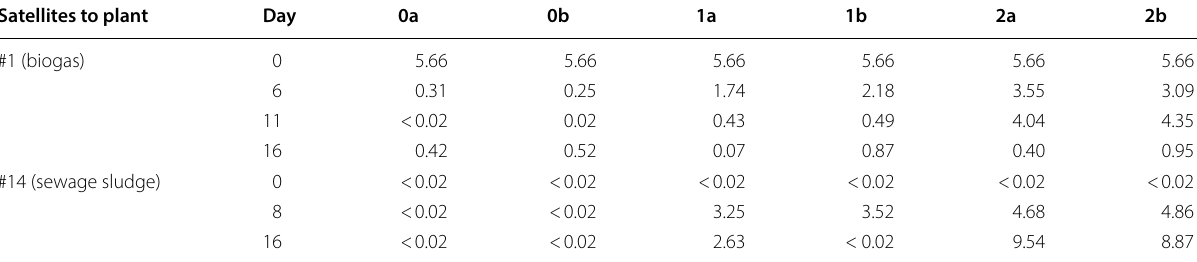
Satellites 0a/b: controls no additional As spike, satellites 1a/b: 30 mM NaAsO 2 , satellites 2a/b: 60 mM NaAsO 2 n.g. not enough gas produced for analysis